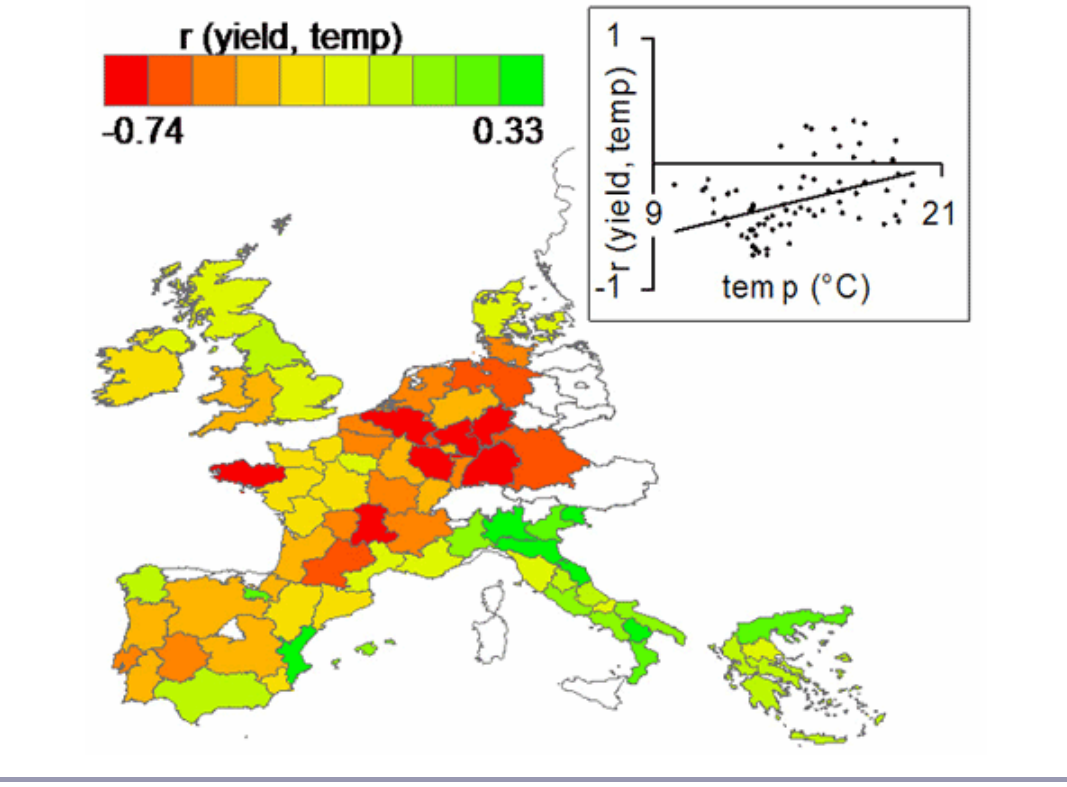
Fig. 2. Spatial distribution of the correlation between inter-annual variability in temperature and wheat yield anomalies [r(yield,temp)], and relationships to average temperature (temp, °C) from 1990–2003. Based on the relationship for spatial variability (Fig. 1), a negative relationship for temporal variability can be expected; this is the case in many temperate regions, but the relationships are often positive in warmer